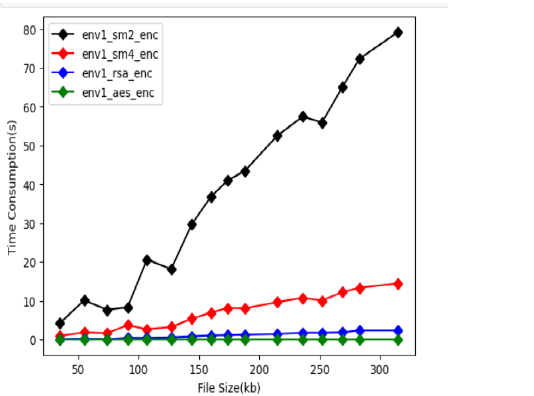
Figure 11. Time consumption of authorization encryption of different experimental samples using SM2, SM4, AES, and RSA in env-1 and env-2.